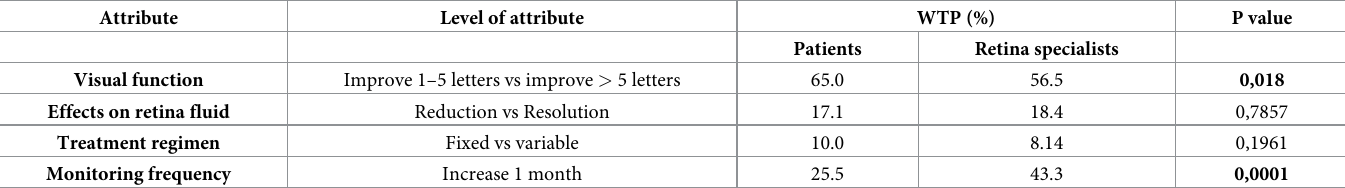
Table 3. Differences in marginal rates of substitution (WTP) between patients and retina